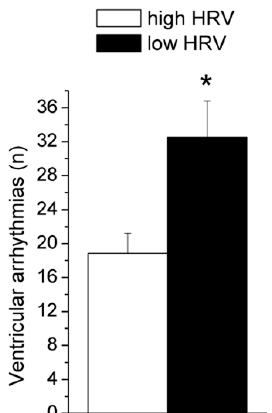
Table 2. Heart rate and lnRMSSD values and number of ventricular arrhythmias before and after the injection of the β -adrenergic agonist isoproterenol in 41 wild-type Groningen rats. Pre-Isoproterenol Post-Isoproterenol